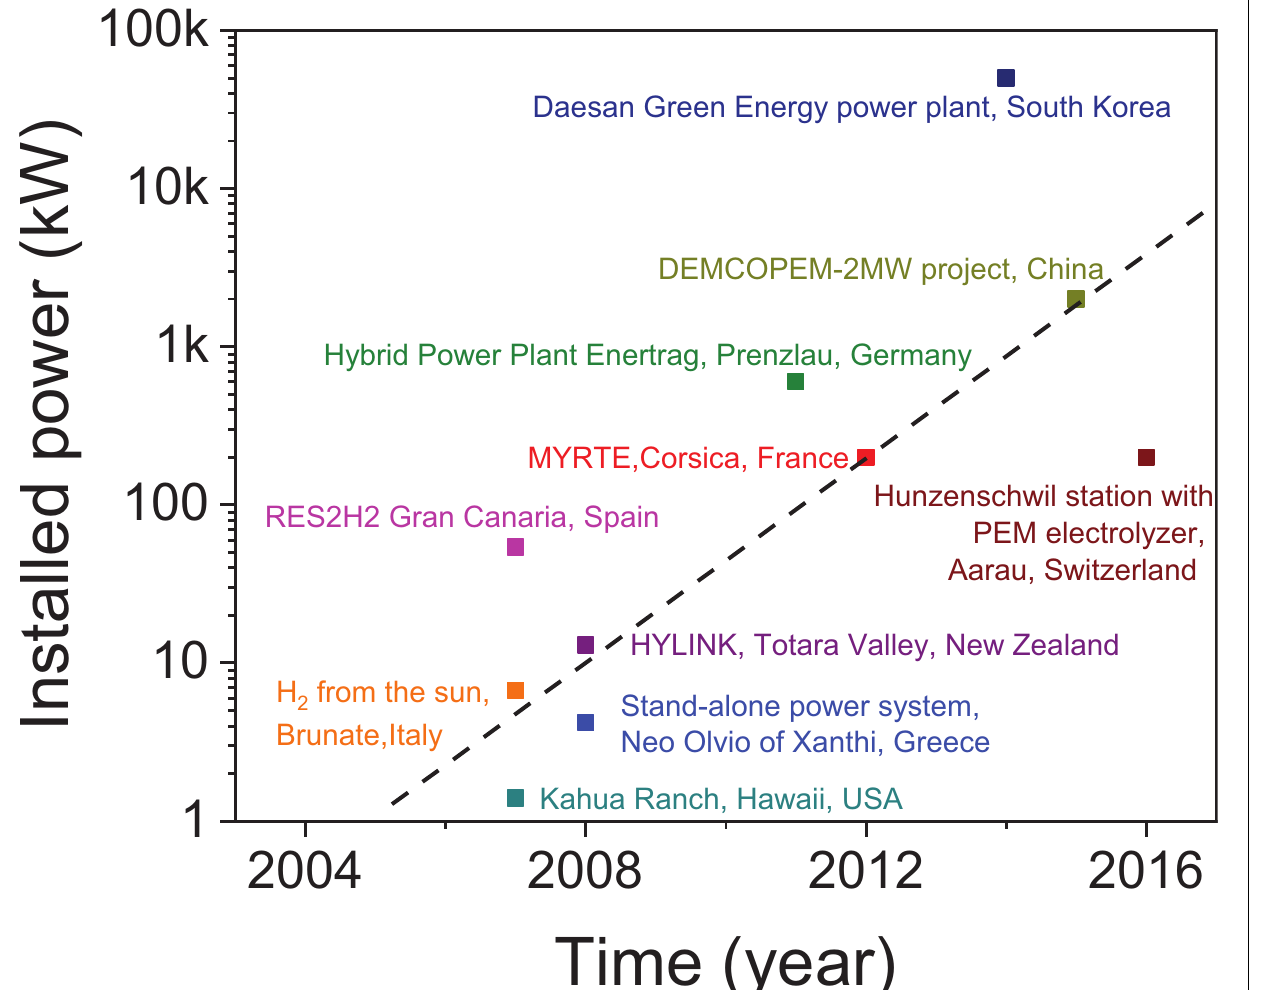
storage tanks using solid state hydrogen materials have the potential to store hydrogen at much higher volumetric densities than compressed and liquefied hydrogen ( Table 1 ), while minimizing the safety risk associated with high pressure hydrogen (Züttel et al., 2010; Lototskyy et al., 2017).